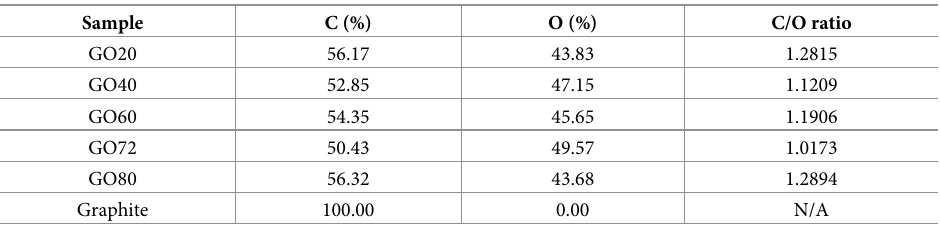
Table 3. Summary of EDX analysis (atomic %) of GO and